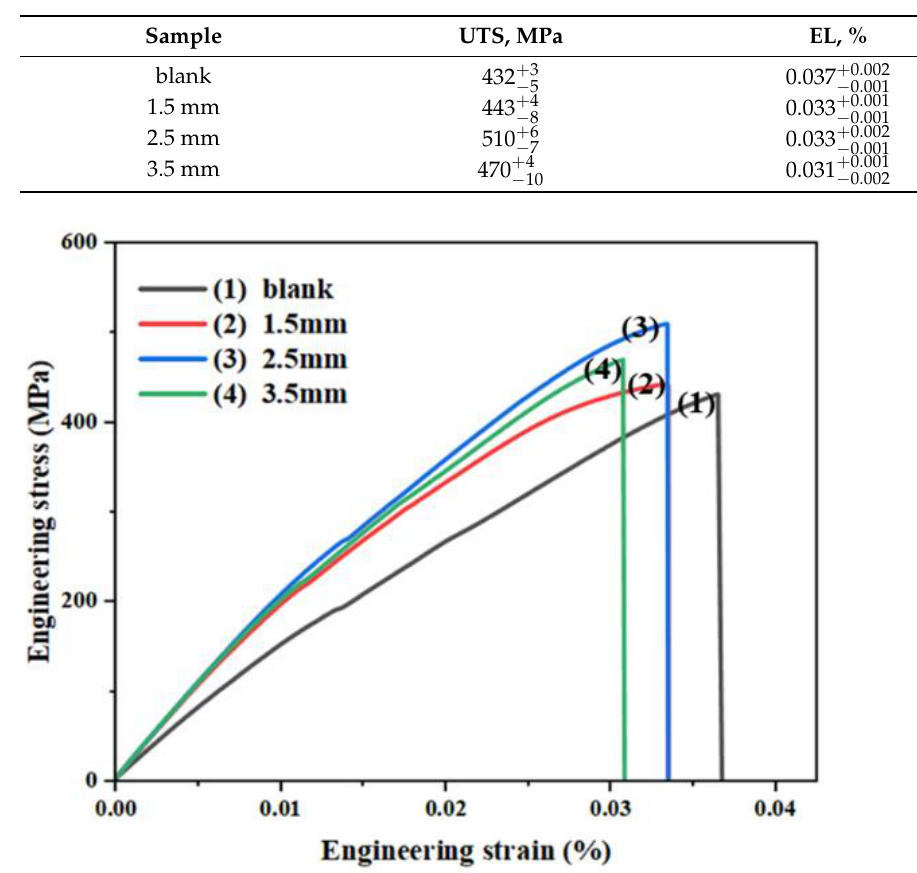
Table 2. Tensile property test results with different unit spacings.